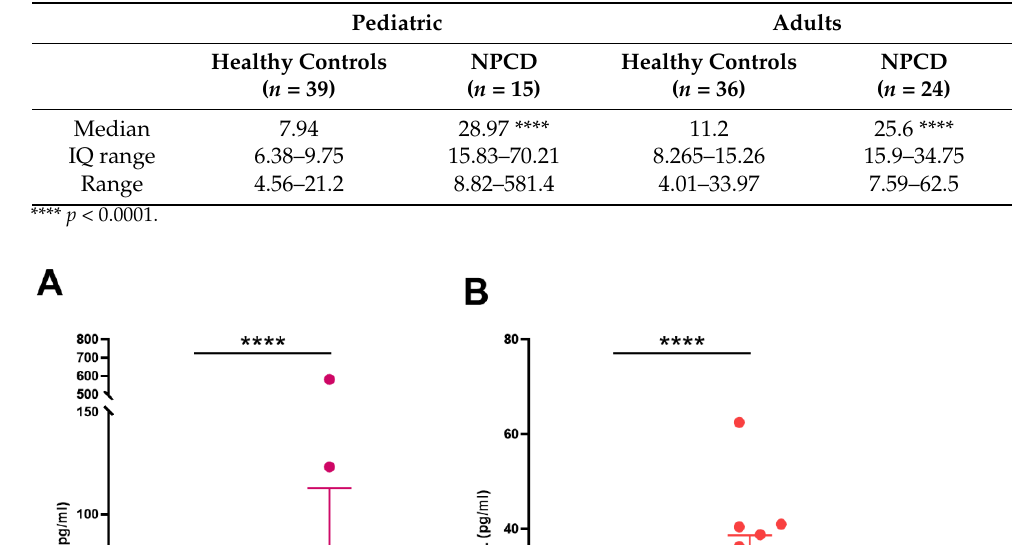
Table 2. Plasma levels of NfL (pg/mL).